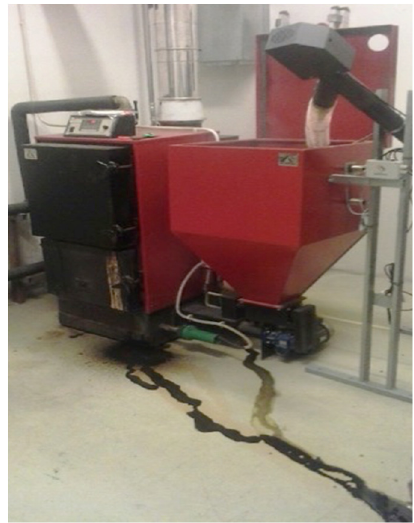
Figure 16. Condensate runoff in a boiler where the torrefied biomass pellets were being tested.